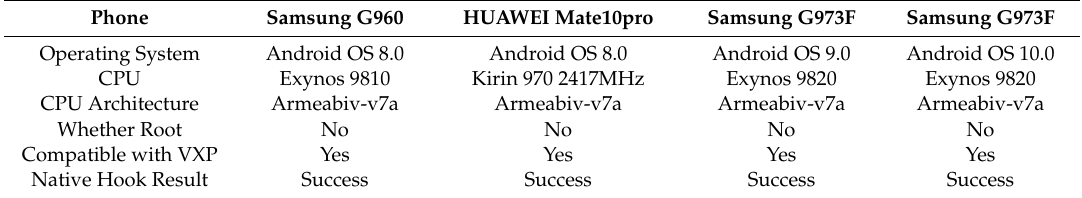
Table 3. Experimental results of Samsung and Huawei in different Android versions.